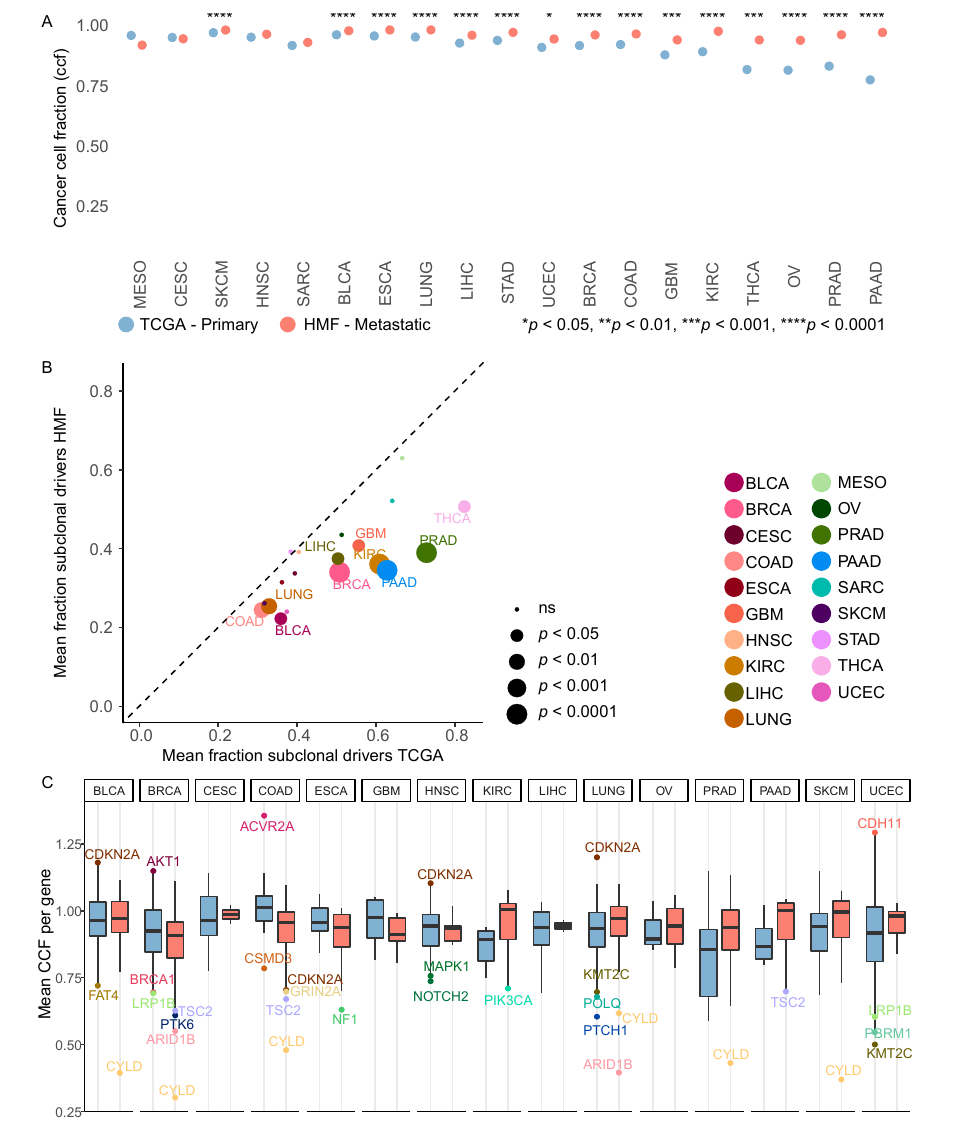
Figure 3. Subclonal mutations. ( A ) Dot plot of the average cancer cell fraction for all mutations in each patient per cancer type, comparing primary and metastatic cancer. ( B ) Scatterplot of the mean fraction of subclonal driver mutations per cancer type comparing primary vs. metastatic cancer. The size of the bubbles represents the significance of the difference in mean between primary and metastatic samples. Colours represent cancer types. ( C ) A boxplot of the mean CCF per gene for all cancer genes with more than 5 hits per cancer type. The outliers are genes with a mean which is more than two standard deviations from the mean of all genes for each cancer type. The lower border of the box represents the 25th percentile, the middle line represents the median, and the upper border represents the 75th percentile.